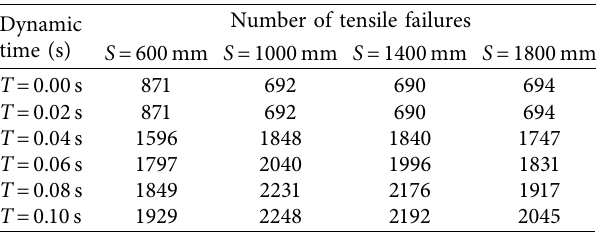
Figure 9: Roadway tensile failure distribution at different grouting lengths: (a) T � 0s; (b) T � 0.1s. Table 14: Number of tensile failures with different grouting Table 15: Roof subsidence with different grouting lengths.